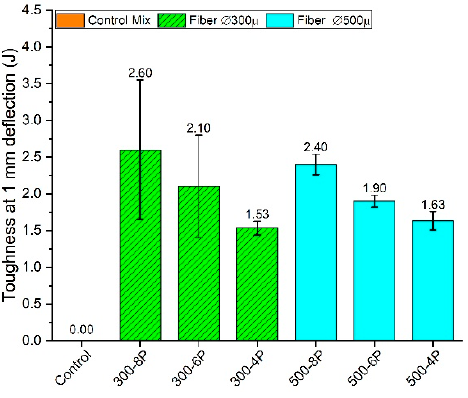
Figure 10. Toughness of the mixtures at 1 mm deflection measured according to RILEM RC 162-TDF [53]. Table 4. Flexural strength and toughness parameters of the four-point bending test.